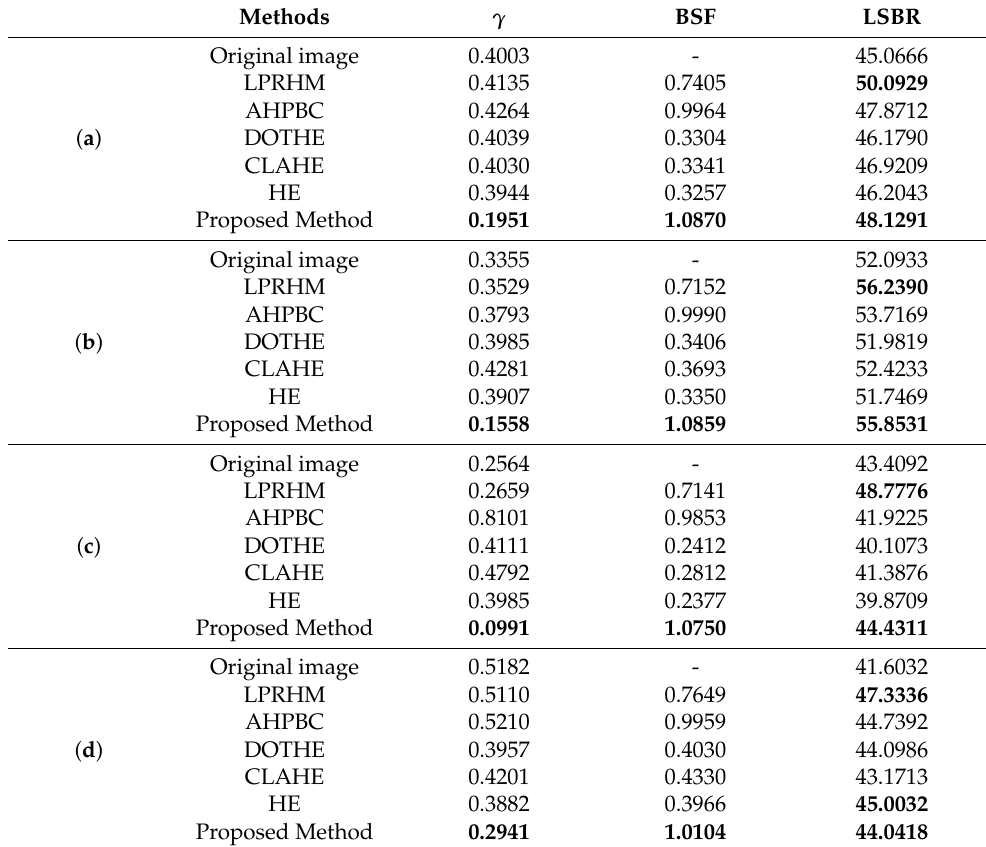
Table 2. The calm sea image quantitative metrics. (a–d) correspond to the calm sea infrared images in Figure 15a–d, respectively. Different methods process the four